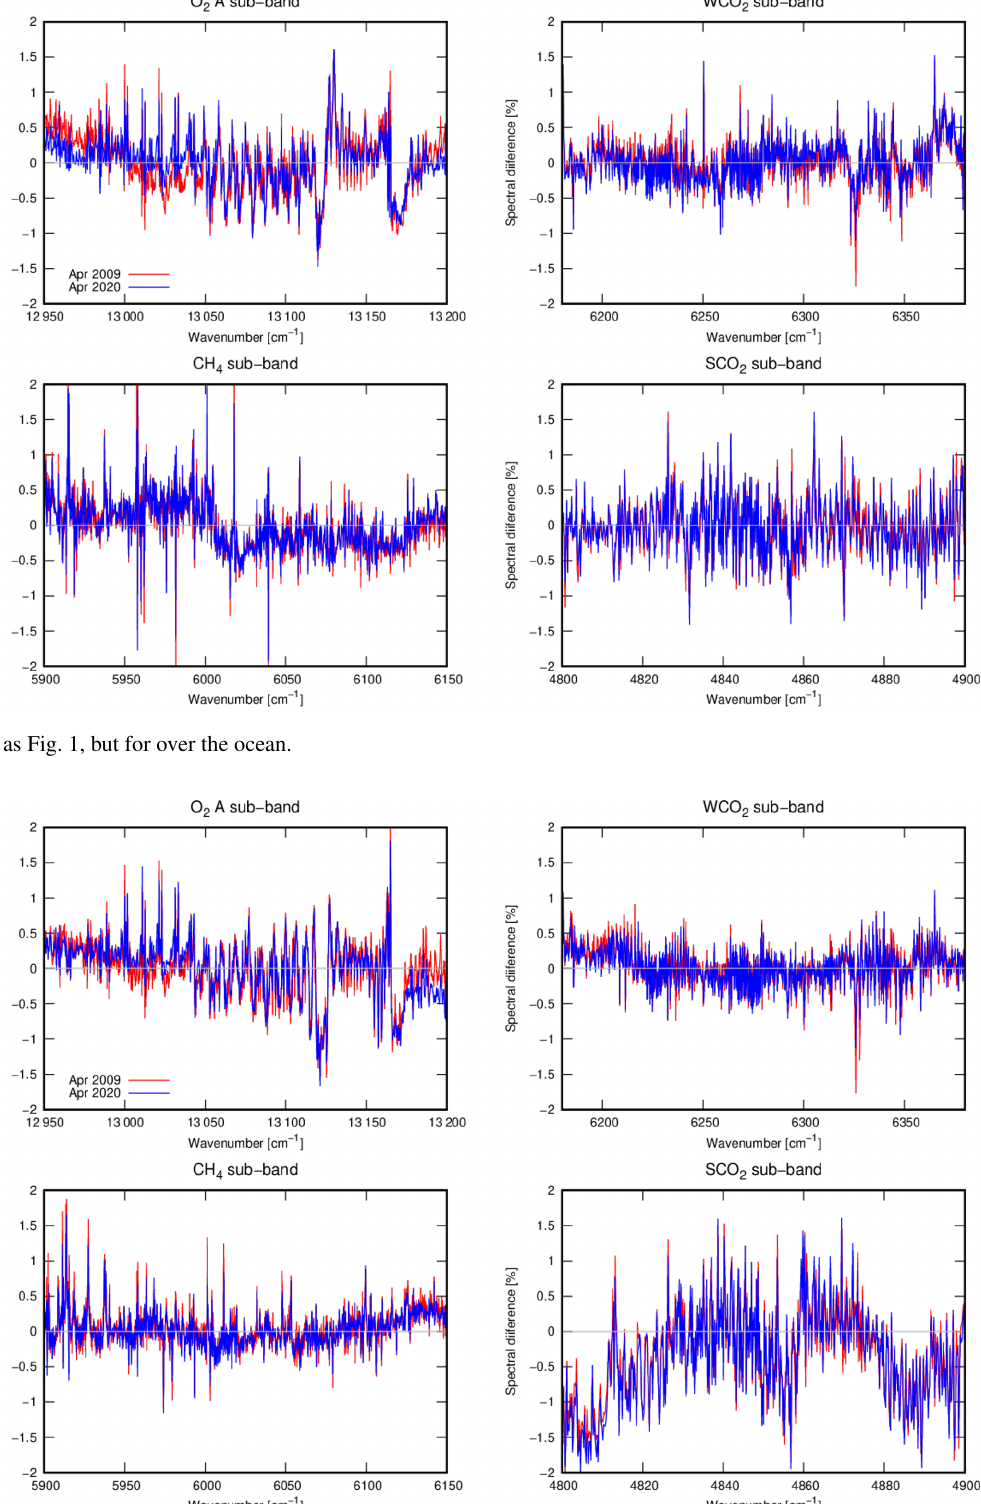
Figure 4. Same as Fig. 3, but for